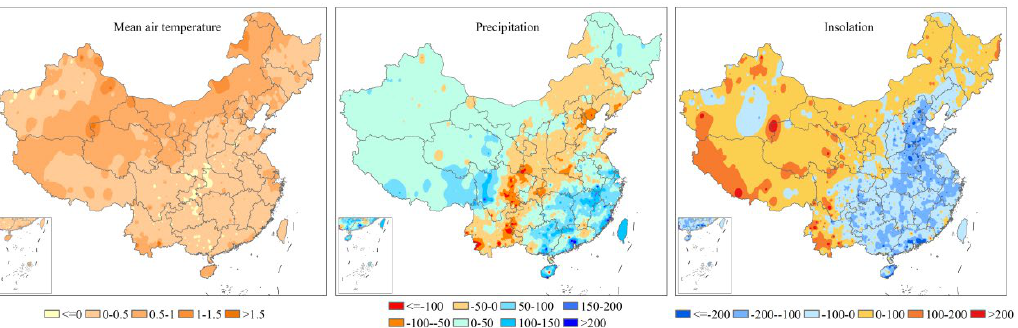
Figure 3. Differences in mean air temperature, precipitation, and insolation during the potential agricultural growing season in 1991–2020 relative to 1961–1990.